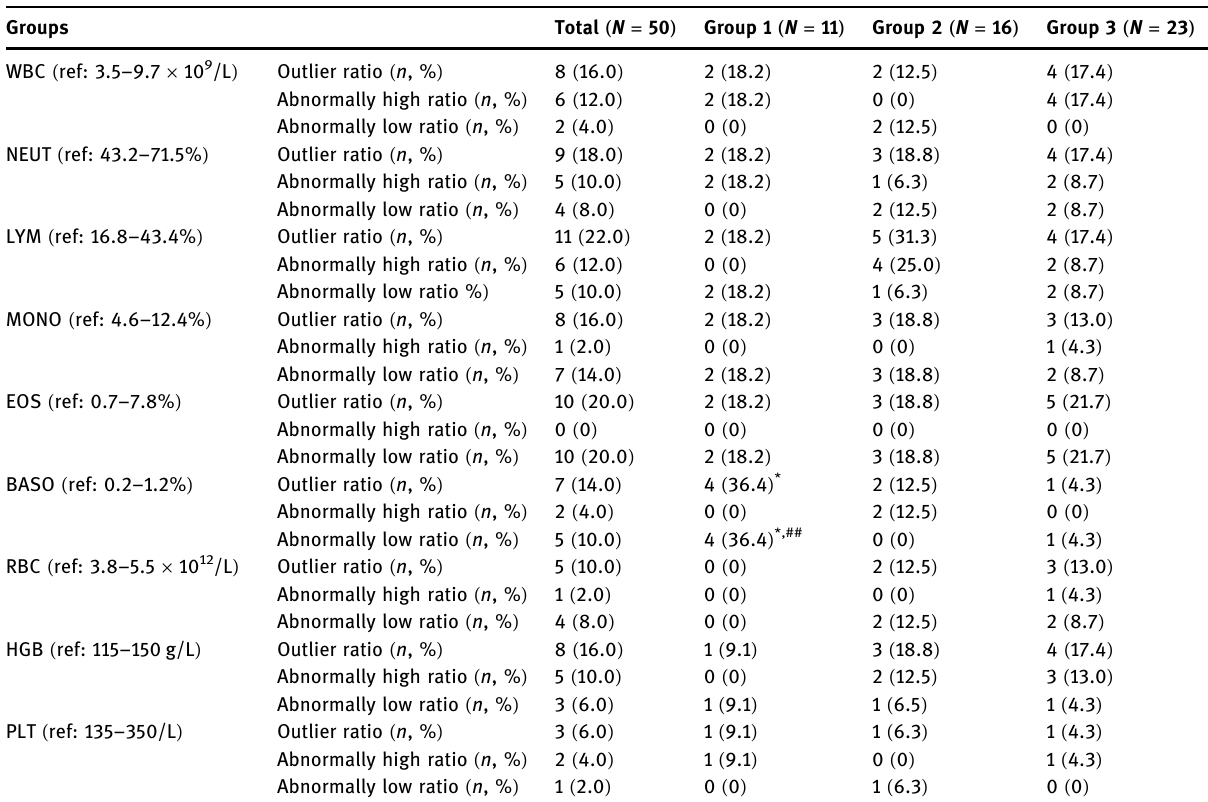
Table 3: Outlier comparison of blood routine test results